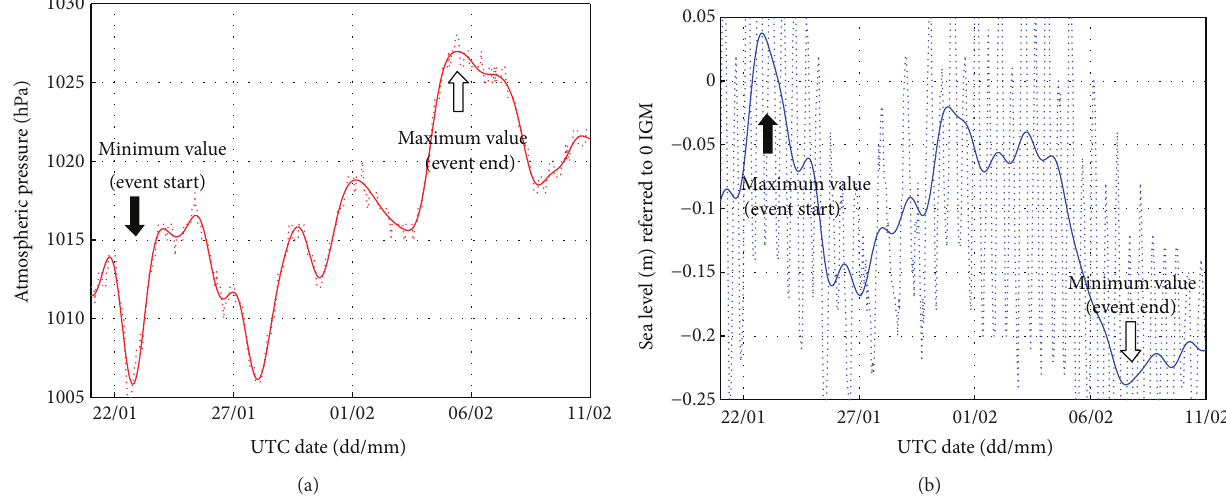
Figure 9: Port of Bari atmospheric pressure and sea level during February 2010 meteo-tide event (dotted line: high frequency, continue line: low frequency, 𝐹 𝑐 = 10 −5 Hz).